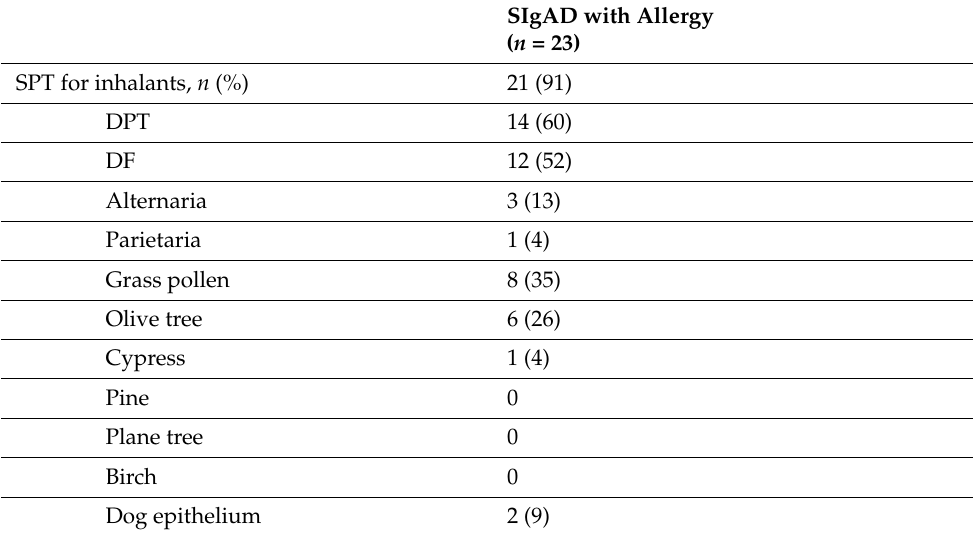
SIgAD with Allergy ( n = 23)